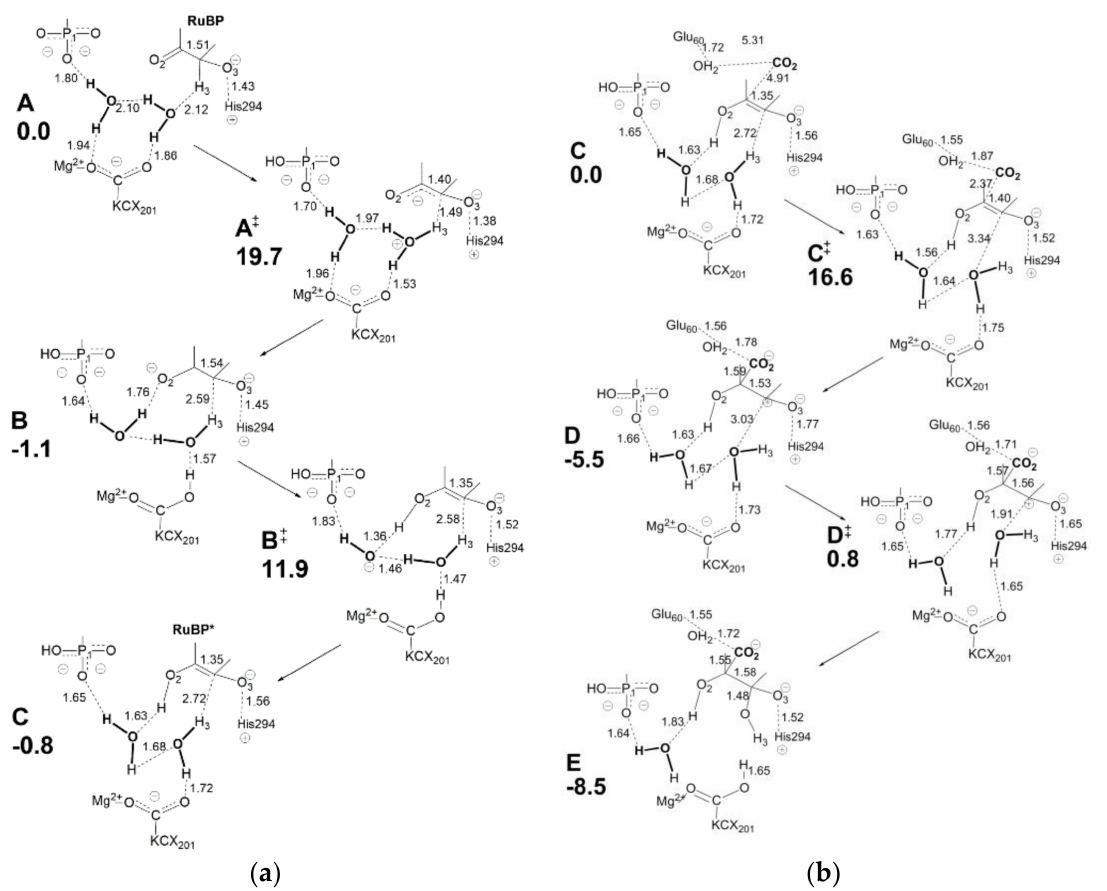
Figure 14. ( a ) Relative potential energies (in kcal/mol) of intermediates (B, C) and transition states (A (cid:54) = , B (cid:54) = ) for RuBP enolization; ( b ) Relative potential energies of intermediates (C, D, E) and transition states (C (cid:54) = , D (cid:54) = ) for the RuBP car- boxylation and hydration steps. (Figure 14 from ref. [43], adapted and used by permission of American Chemical Society (copyright ©